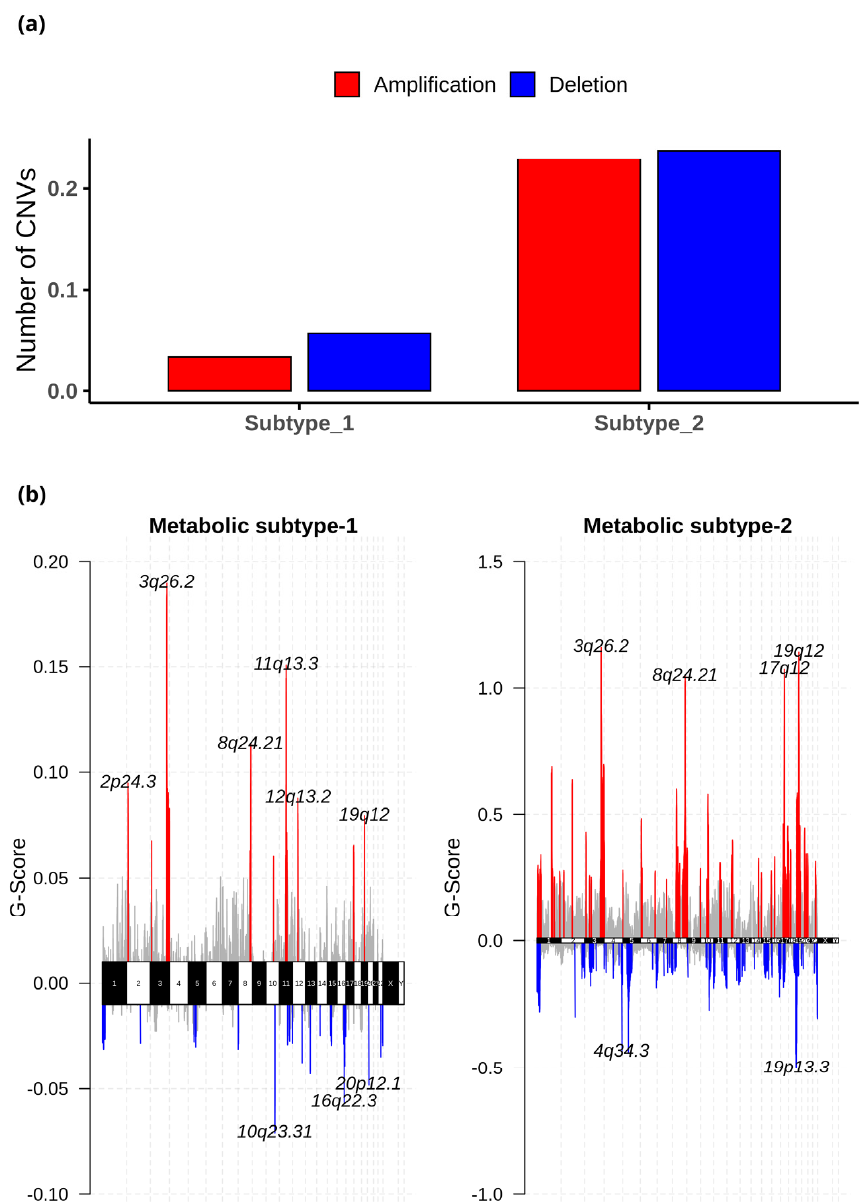
Figure 9. ( a ) The average number of significant CNVs in metabolic subtype-1 and subtype-2 samples. ( b ) The genome plot shows the G-score of significant CNVs of metabolic subtype-1 and metabolic subtype-2 samples for all chromosomes. The red and blue colors represent the amplifications and deletions, respectively. The grey color represents the non-significant CNVs.